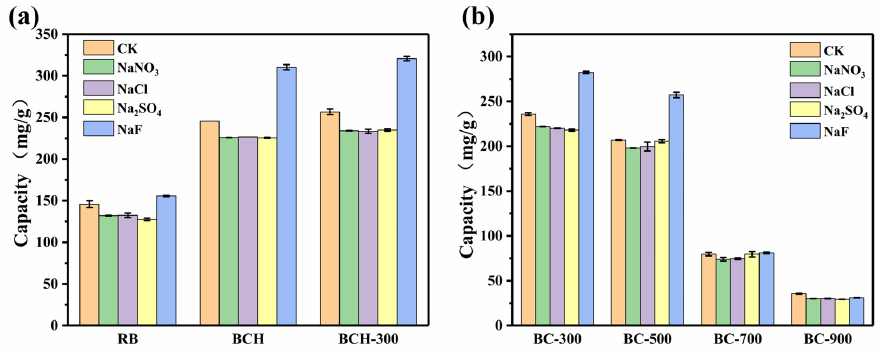
Figure 5. Effect of various ionic species on sorption performance ( a , b ).